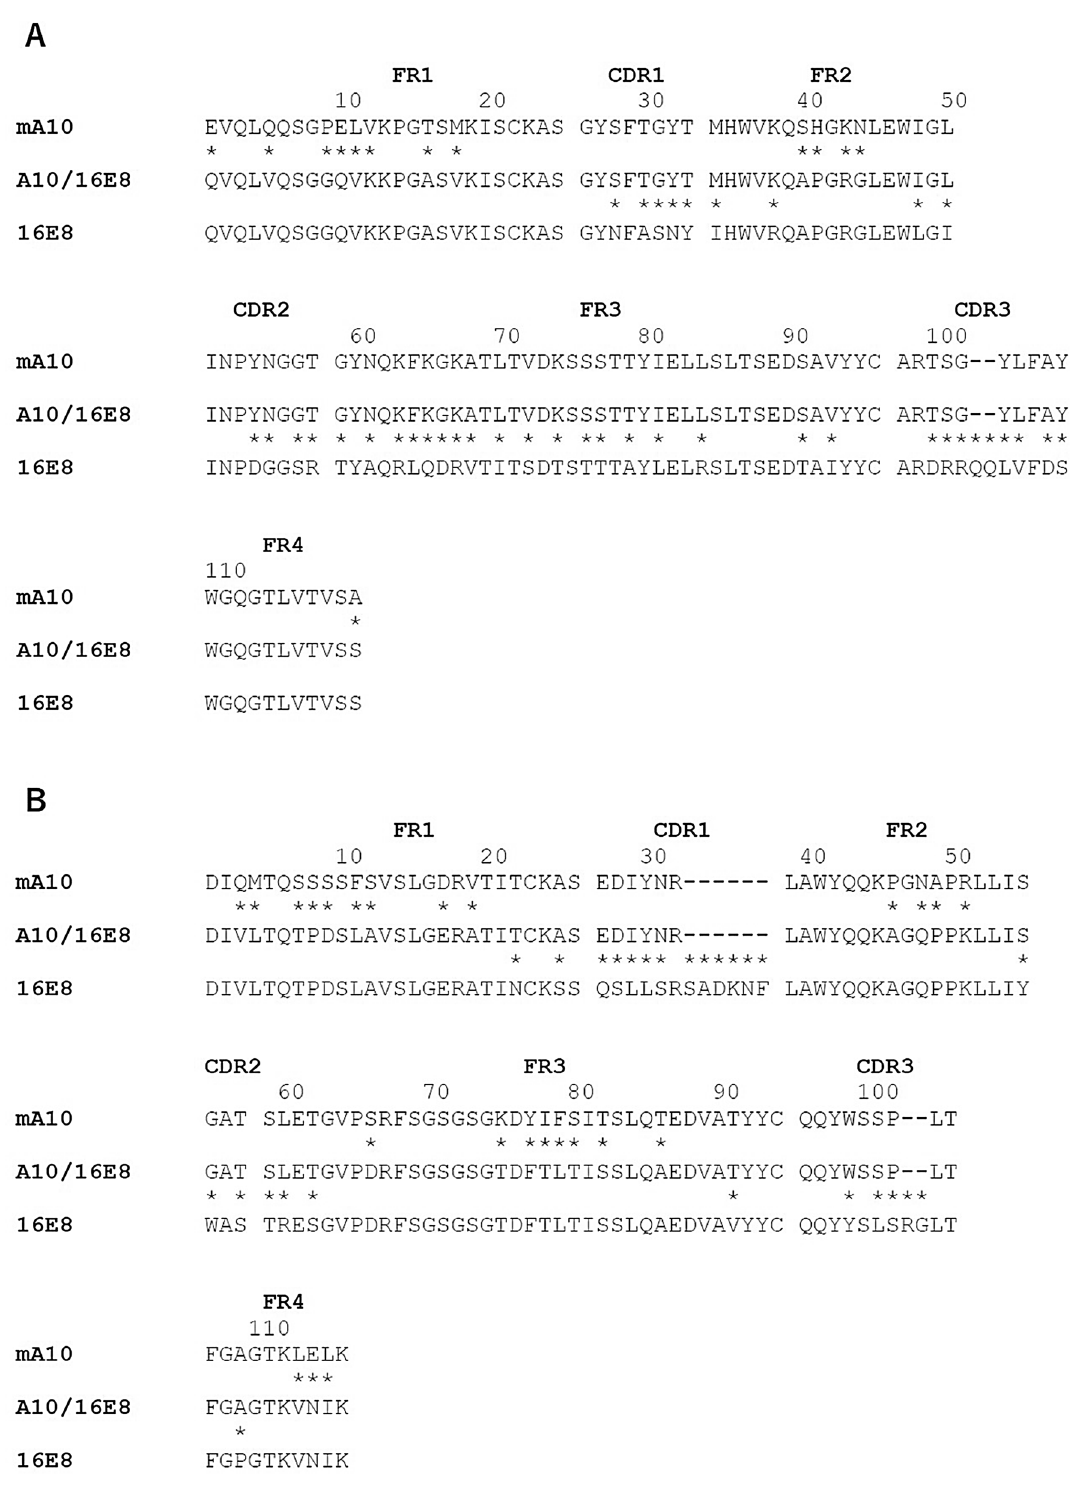
Figure 2. Amino acid sequence alignment of the heavy ( A ) and light ( B ) chain variable domains of mouse A10 (mA10), humanized A10/16E8, and human antibody framework 16E8. The FRs and CDRs in the variable domains of mouse or human antibody sequences were determined by IMGT numbering scheme, respectively. Asterisks (*) indicate the difference between each paired amino acid sequence, and hyphens (−) indicate